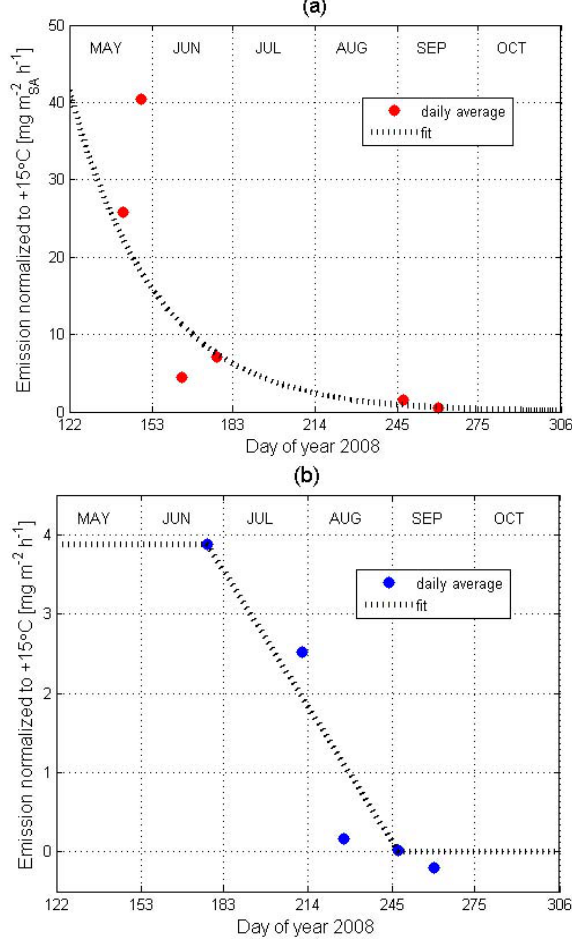
Fig. 4. The monoterpene emissions normalized to +15 ◦ C calcu- lated from the daily averaged emission measurements. (a) Red dots are the emissions from the Scots pine stump and the dotted black line the fit used in the upscaling. (b) Blue dots are the ecosystem scale emissions and the dotted black line is the fit used in the up- scaling. See text for details of the fitted